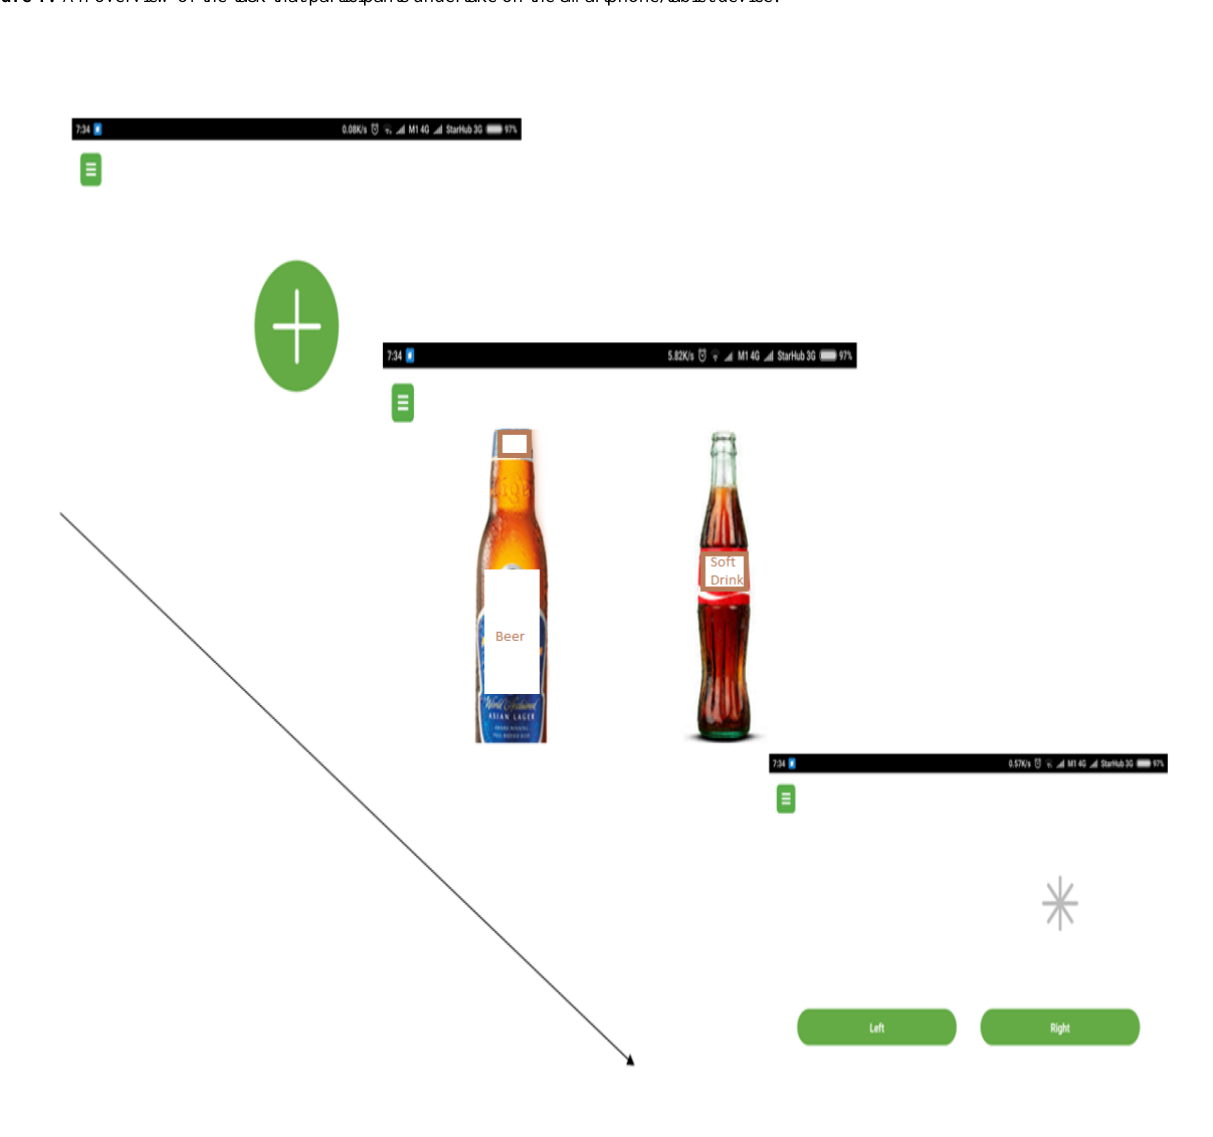
Figure 1. An overview of the task that participants undertake on the smartphone/tablet device.